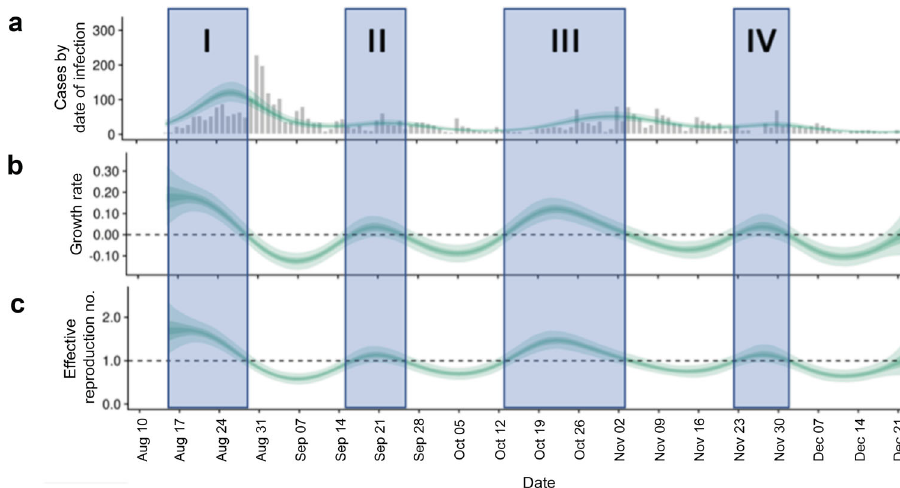
Fig. 4 Epidemiological analysis for COVID-19 cases on campus. a Cases estimated by date of infection. b Estimated growth rate. c Estimated effective reproduction number R eff by the date of infection as a function of time using the method of Cori et al. assuming gamma-distributed generation time distribution 62 and a distribution between consecutive tests shown in Supplementary Fig. 7. The shaded periods (I – IV) correspond to periods of the semester when R eff > 1 suggesting transient growth of cases. The unshaded time periods correspond to R eff < 1 suggesting that the epidemic is controlled, and cases are decreasing. In each subplot, the credible intervals for the calculation of that output are shown with three shades. These three shades correspond to credible intervals of 20% (darkest green), 50% (lighter green), and 90% (lightest green). Analysis was done using Epidemiological toolbox EpiNow2 46 . Please see the “ Methods ” section for more